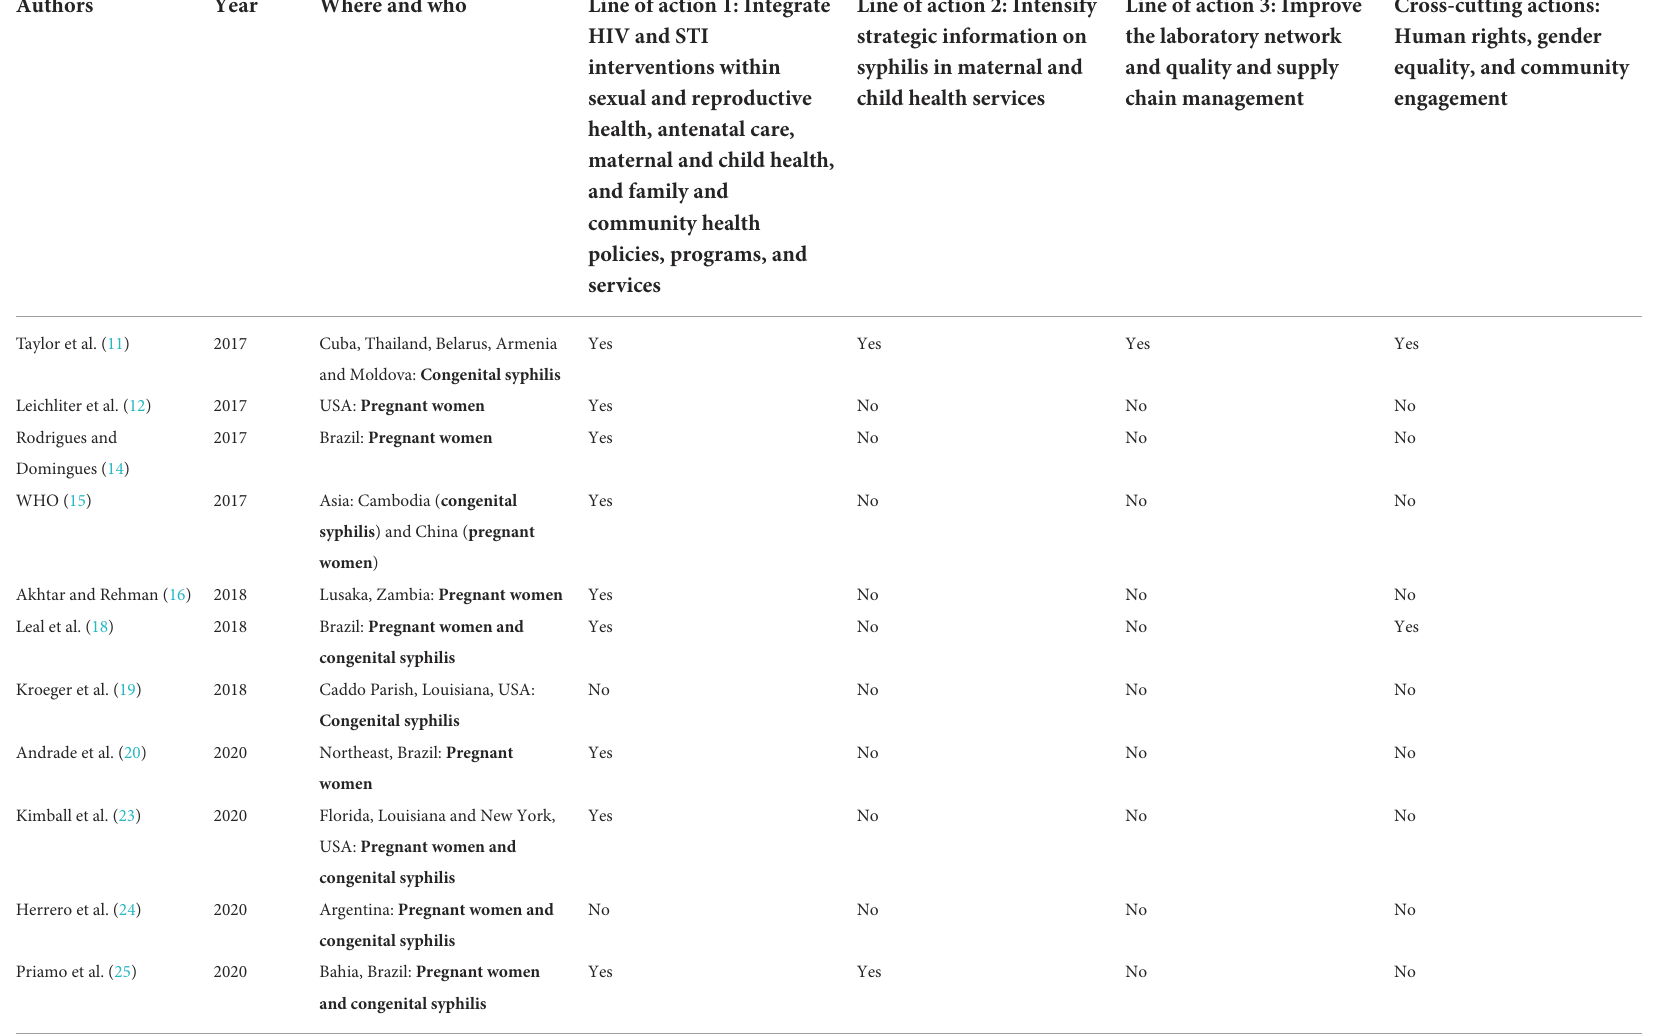
TABLE 2 Lines of action implemented according to the PAHO/WHO 2017 framework.